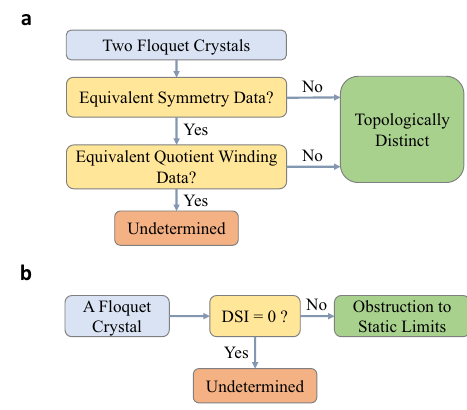
Fig. 1 Brief summary of main results. a The fl owchart for topologically classifying Floquet crystals based on symmetry data and quotient winding data. b The fl owchart for using DSI to indicate obstruction to static